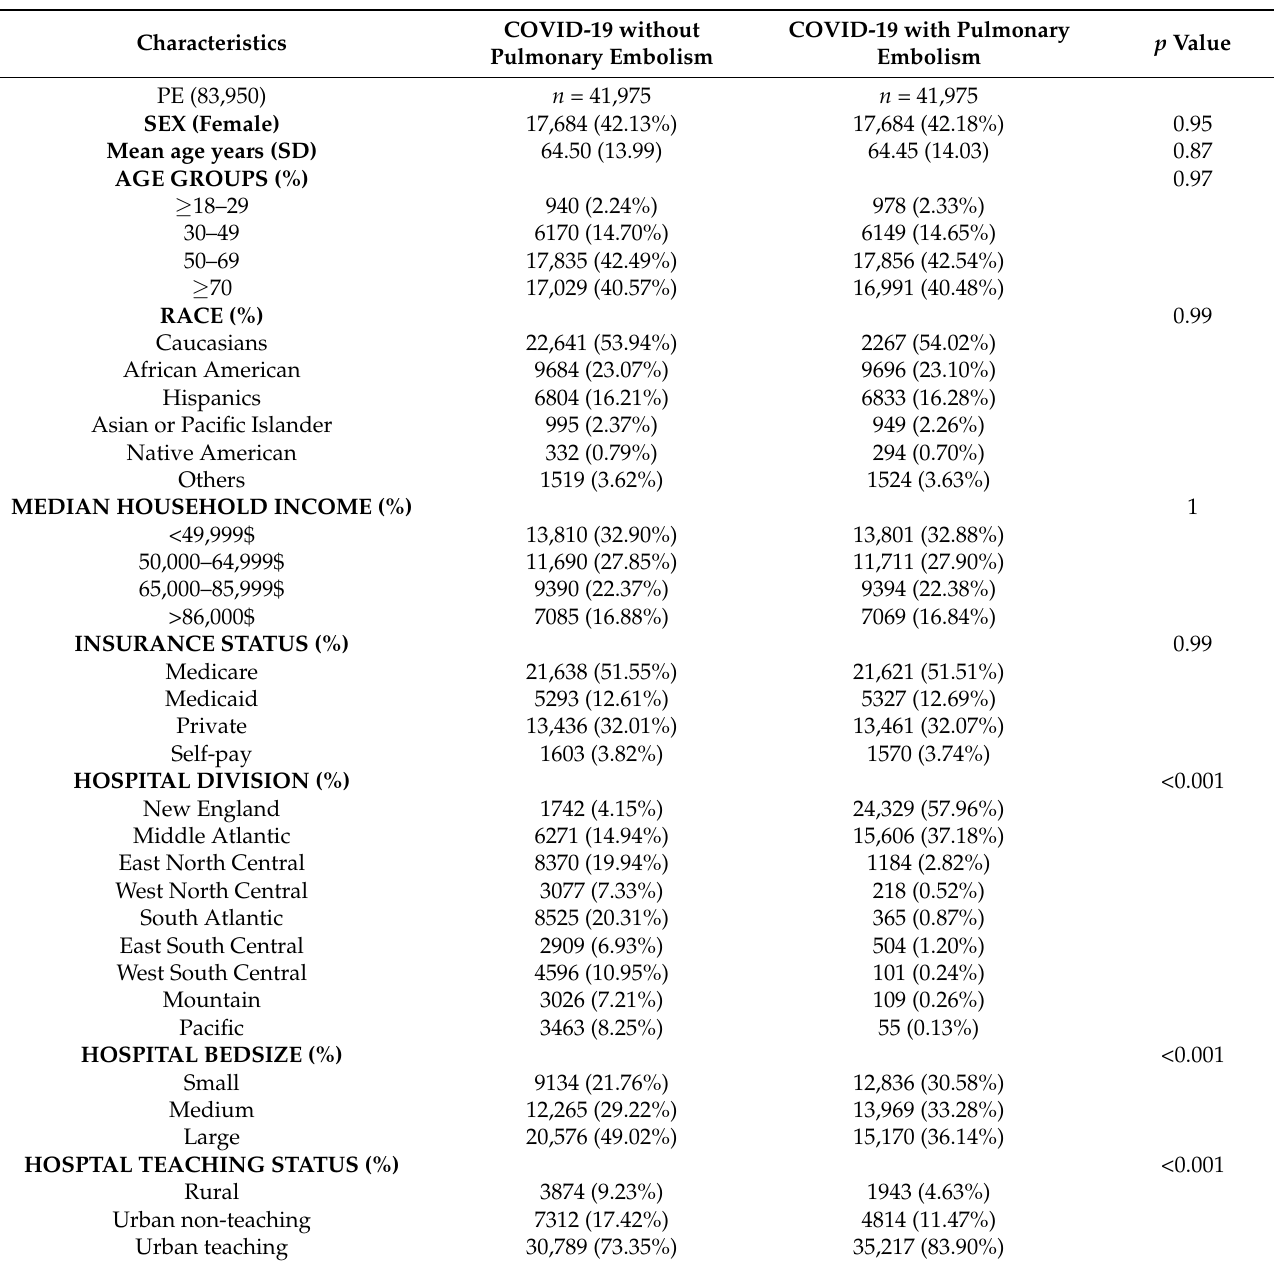
Table 2. Patients with COVID-19 with and without pulmonary embolism propensity 1:1 matched patient-level